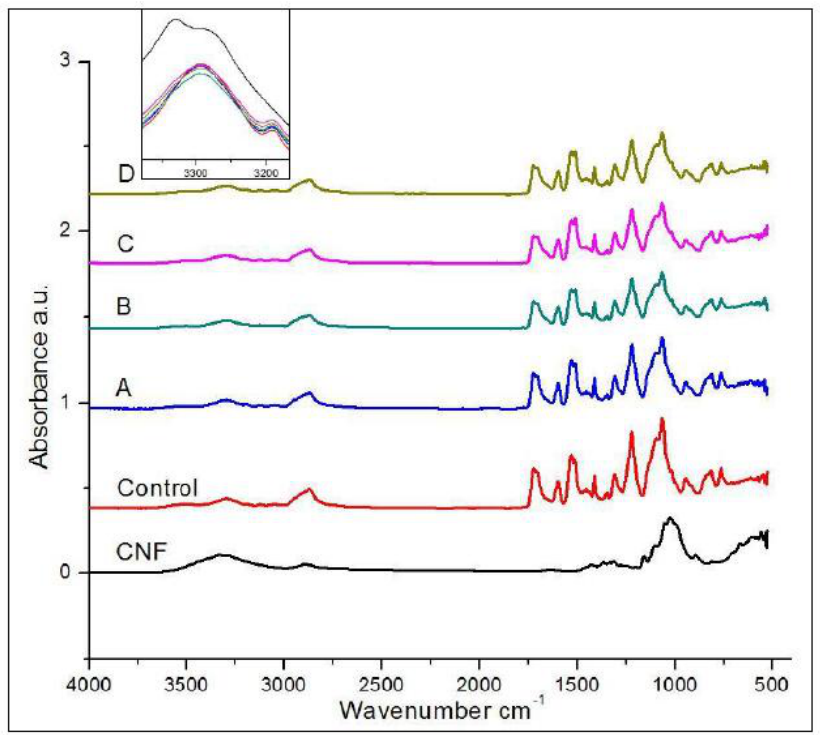
Figure 2. FTIR spectra of CNF, PUF control, and CNF-PUF with 10–40% CNF replacement ratios.